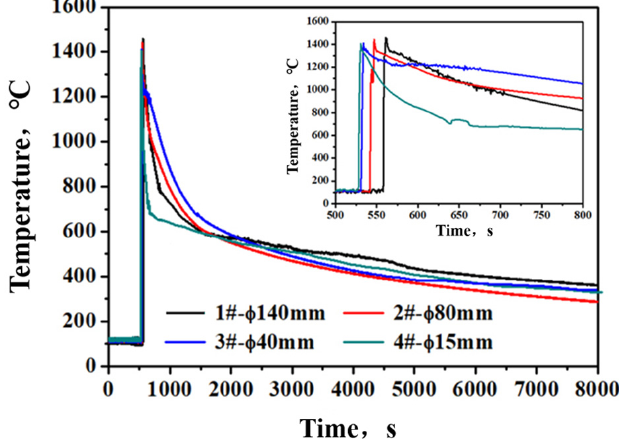
Figure 5. Cooling curves of the ingot with different diameters during pouring. Table 2. Average cooling rate of billets with different diameters during solidification. Ingot Position